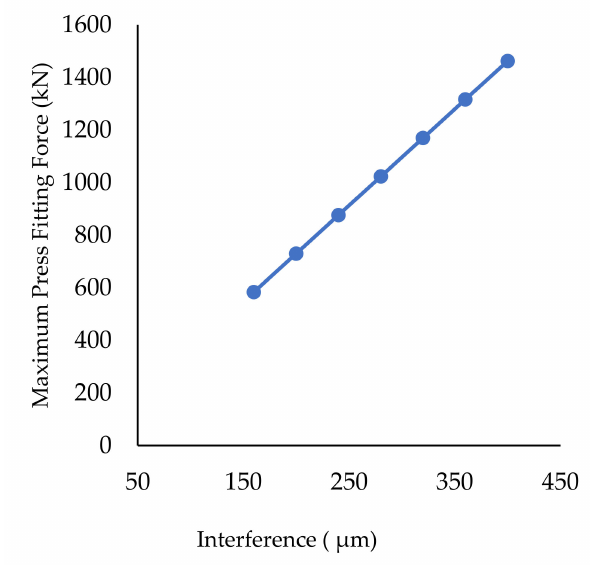
Figure 11. Maximum press-fitting force vs interference.